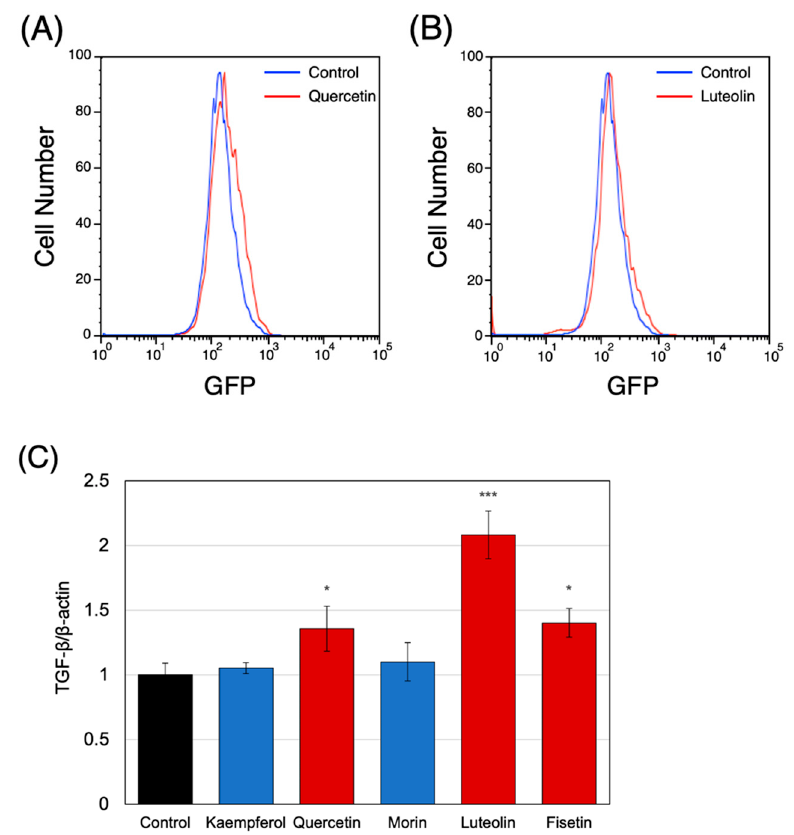
Figure 2. Quercetin and luteolin activated the endogenous RALDH enzymatic activity in THP-1 cells. Enzymatic activity of RALDH2 in differentiated THP-1 cells treated with ( A ) quercetin and ( B ) luteolin were measured using the ALDEFLUOR staining kit. ( C ) Quercetin and luteolin treatment increased the TGFB1 mRNA expression level in the differentiated THP-1 cells. Two-sided Student’s t -test was used to test for significant differences compared to results of the controls. Significance was defined as * p < 0.05, *** p < 0.001. RALDH2: retinaldehyde dehydrogenase 2; TGFB1: transforming growth factor beta